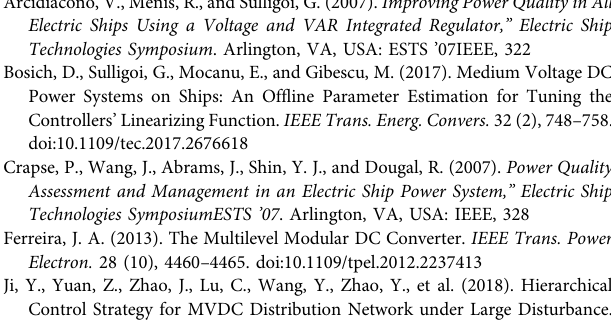
Frontiers in Energy Research |